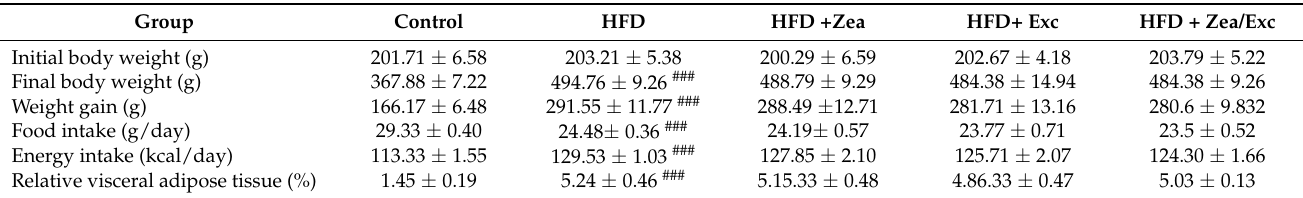
Table 1. Effects of Zea and Exc on body weight, weight gain, food intake, and relative visceral adipose tissue in HFD-induced obese rats.